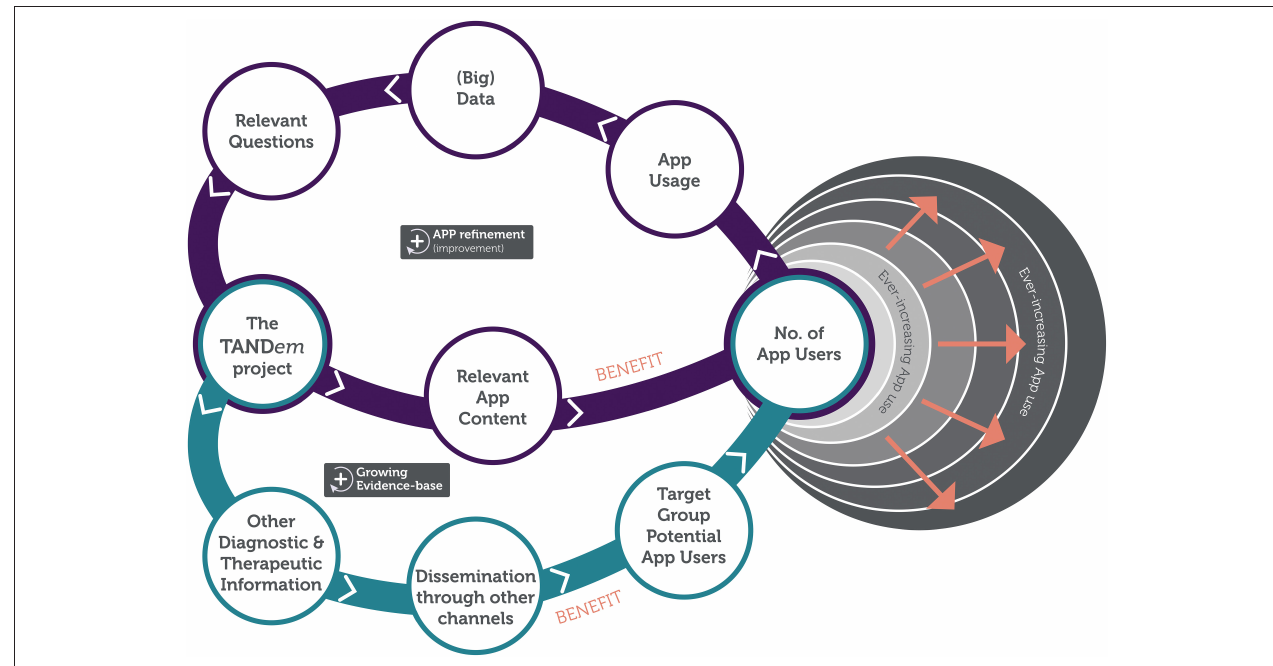
FIGURE 4 | TANDem project impact